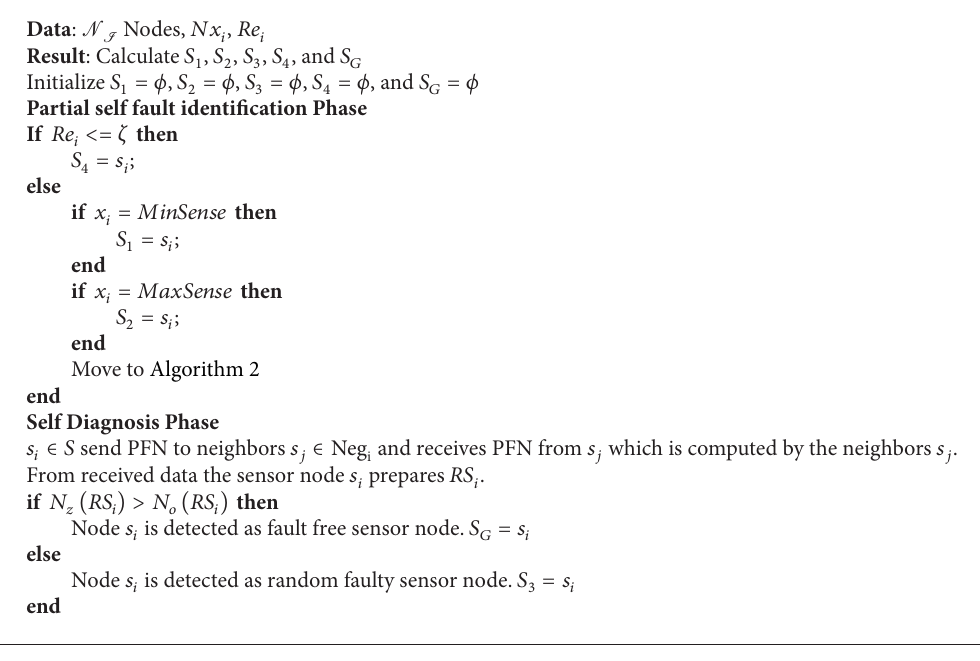
Algorithm 1: Distributed fault identification in WSN.